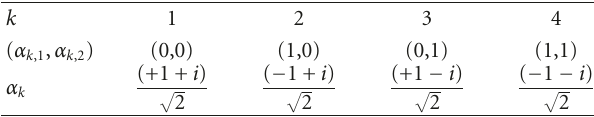
Table 1: QPSK symbol